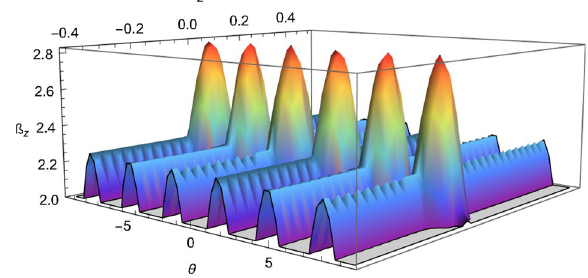
Figure 3. Plot of the inequality (15), taking z ′ 0.01 and time t 2.2 , p µ cb / 2 z = =